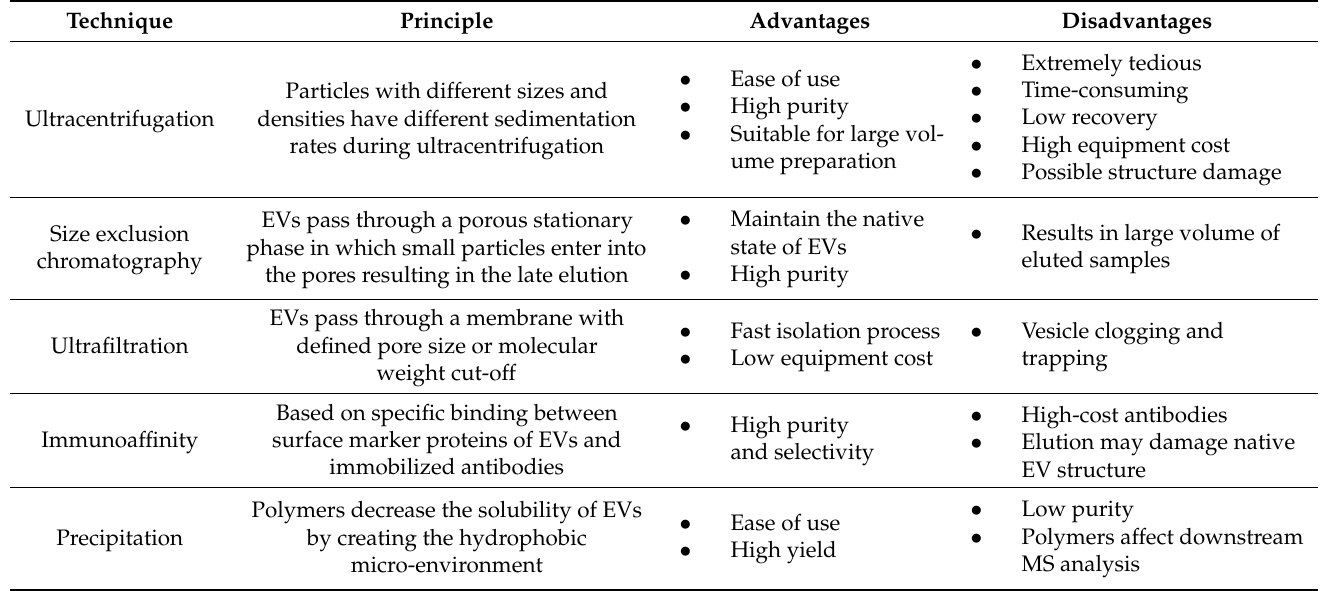
Table 1. Summary of the commonly used EV isolation